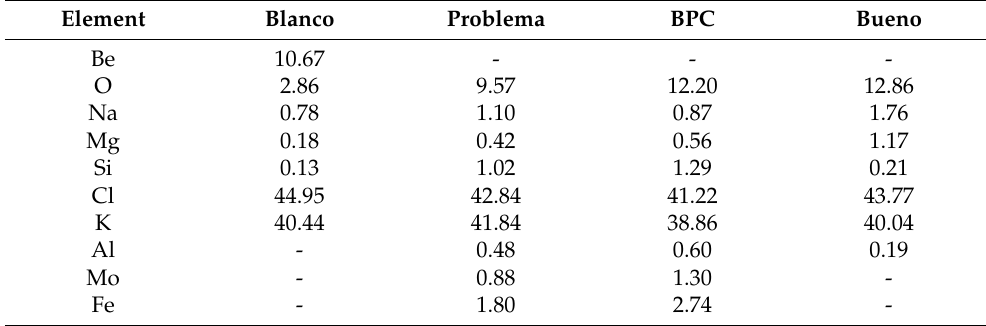
Table 5. Percentage composition of chemical elements in KCl minerals (Wt%).